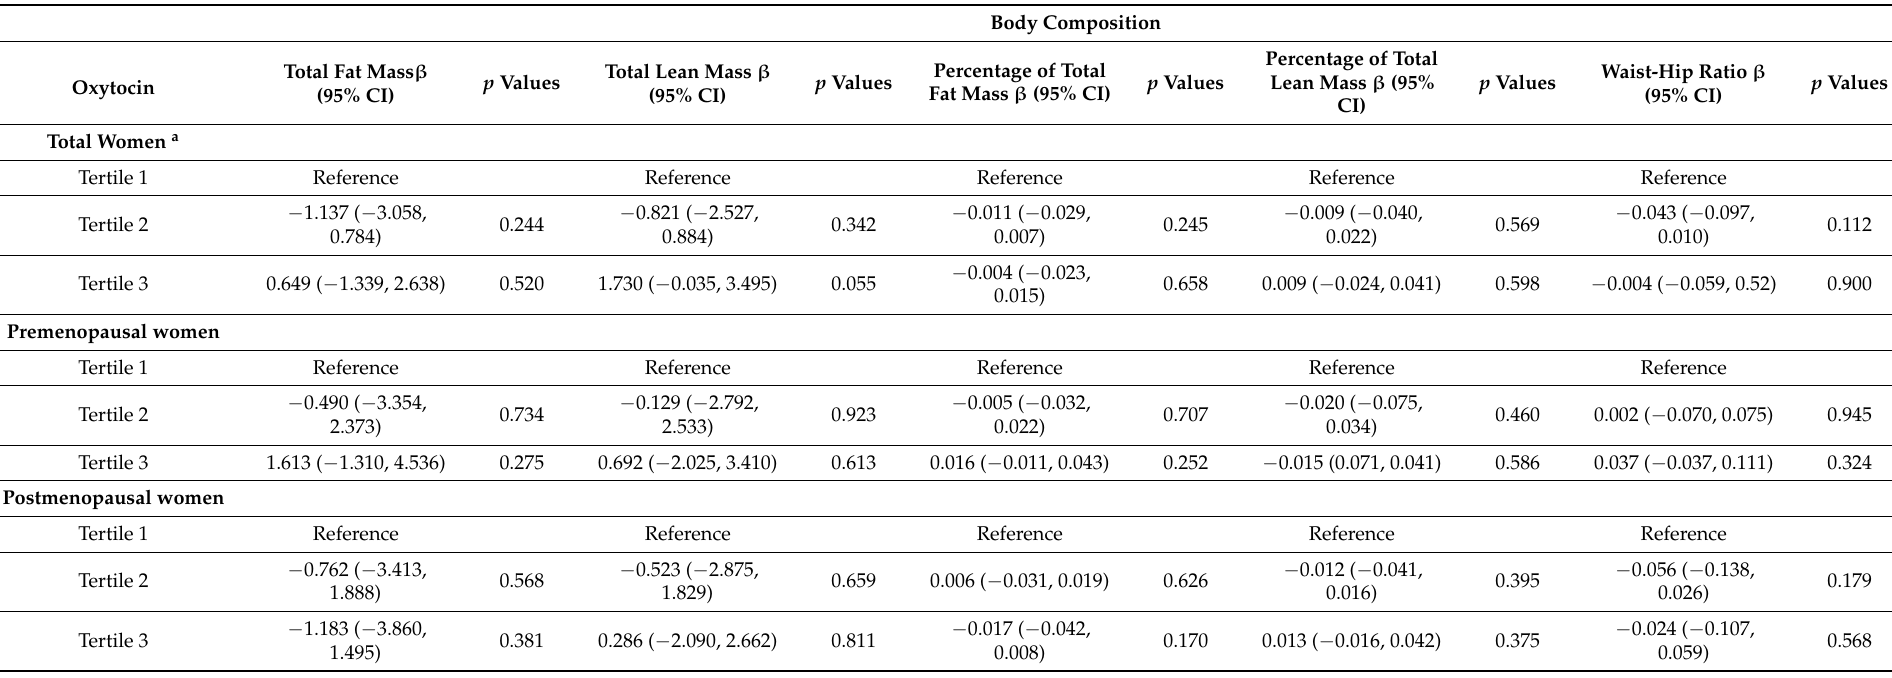
Table 3. Association between serum oxytocin level and body composition in Chinese adult women by menopausal status.